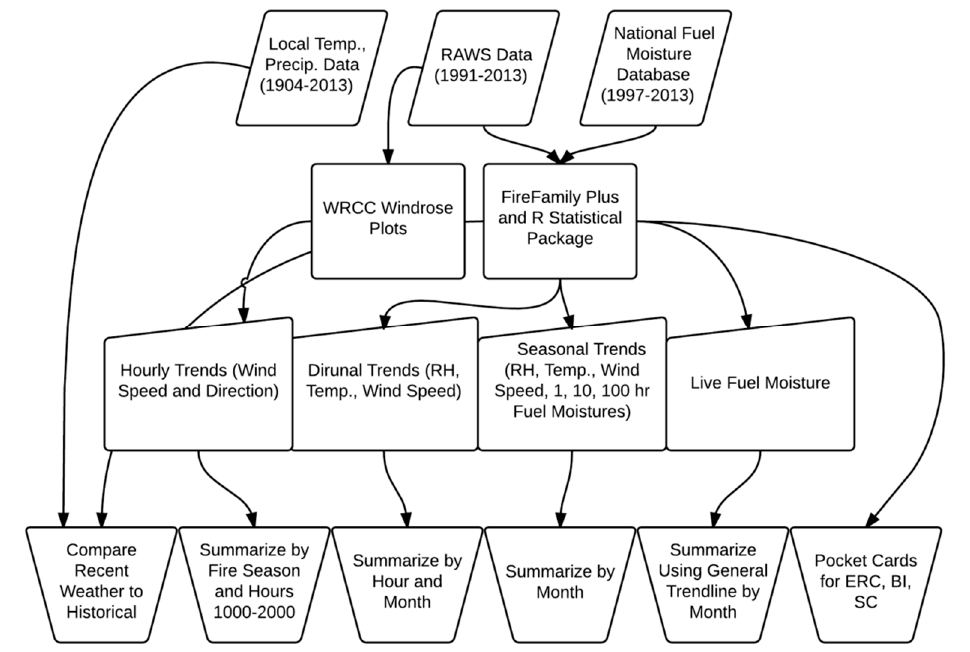
Figure 3. Flow chart of methodology used to summarize weather using remote automated weather station (RAWS) data, local weather observation data, and National Fuel Moisture Database live fuel moisture content data. RH = relative humidity, ERC = energy release component, BI = burning index, SC = spread component and WRCC = Western Regional Climate Center.